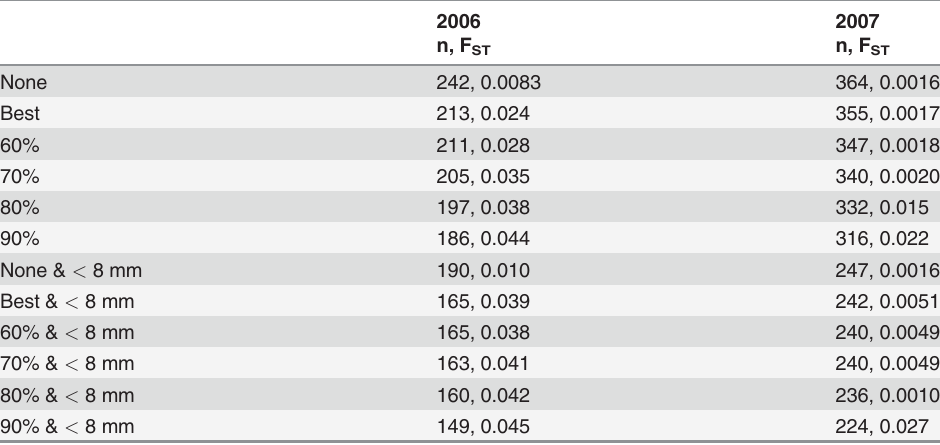
Sample sizes (n) are included. Rows indicate con fi dence in hatch-location assignment: None: null assignments based on capture location; Best: assigned to single most likely hatching location (SS or NS) based on backtracking; 60%: assigned to hatching location with at least 60% con fi dence; 70%: assigned to hatching location with at least 70% con fi dence; 80%: assigned to hatching location with at least 80% con fi dence; 90%: assigned to hatching location with at least 90% con fi